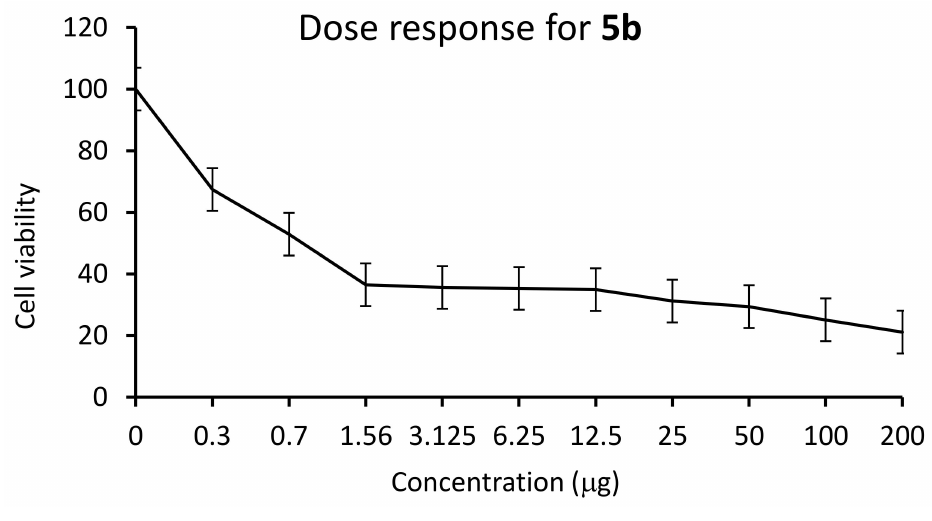
Figure 3. Dose-response of compound 5b .